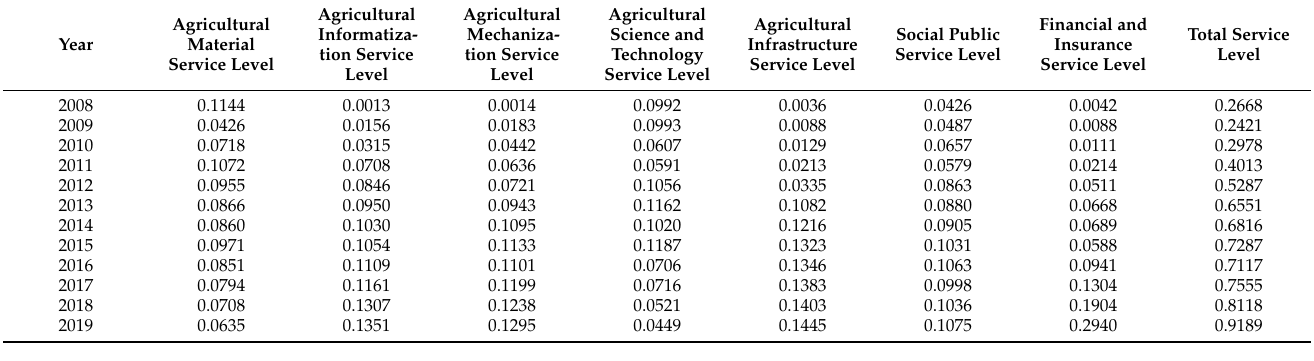
Table 2. Entropy model measurement results for agricultural socialized service levels.